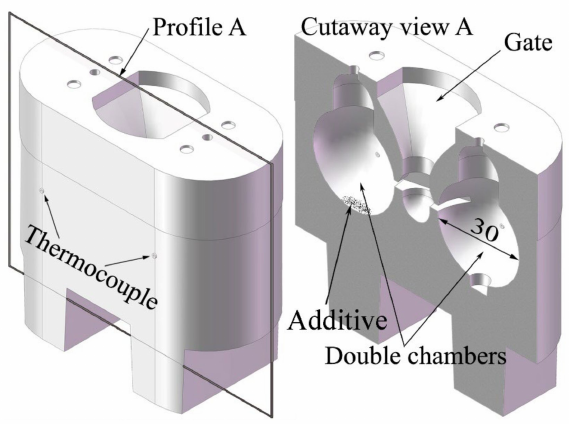
Figure 1. Structure and size of the double-chamber sample